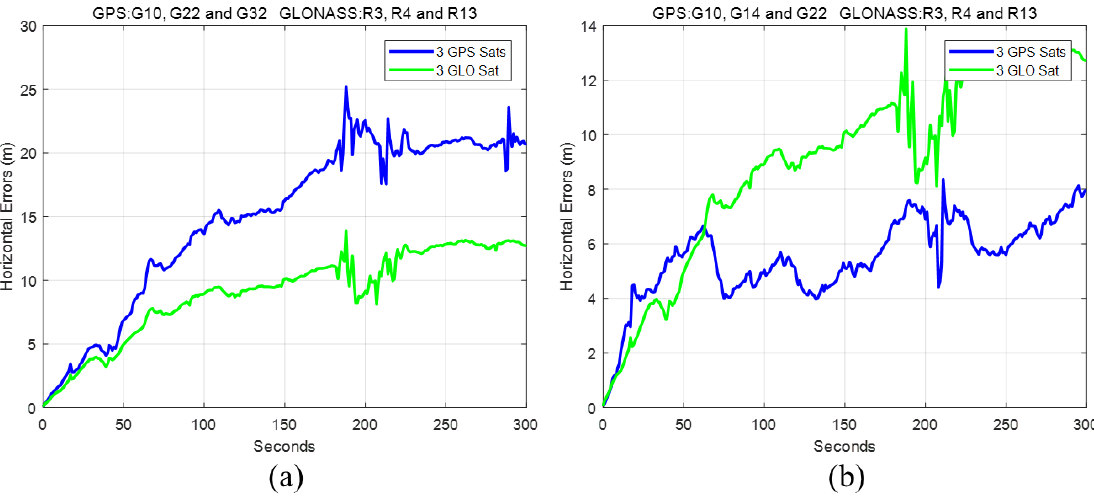
Figure 7. Horizontal errors with 3 GPS and 3 GLONASS satellites. ( a ) GPS satellites: G10, G22 and G32; ( b ) GPS satellites: G10, G14 and G22.